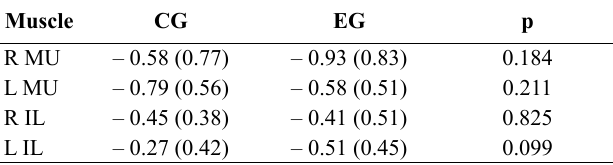
Table 2. Comparison of the median frequency slope coefficients ob - tained during the Biering-Sorensen test (mean and standard